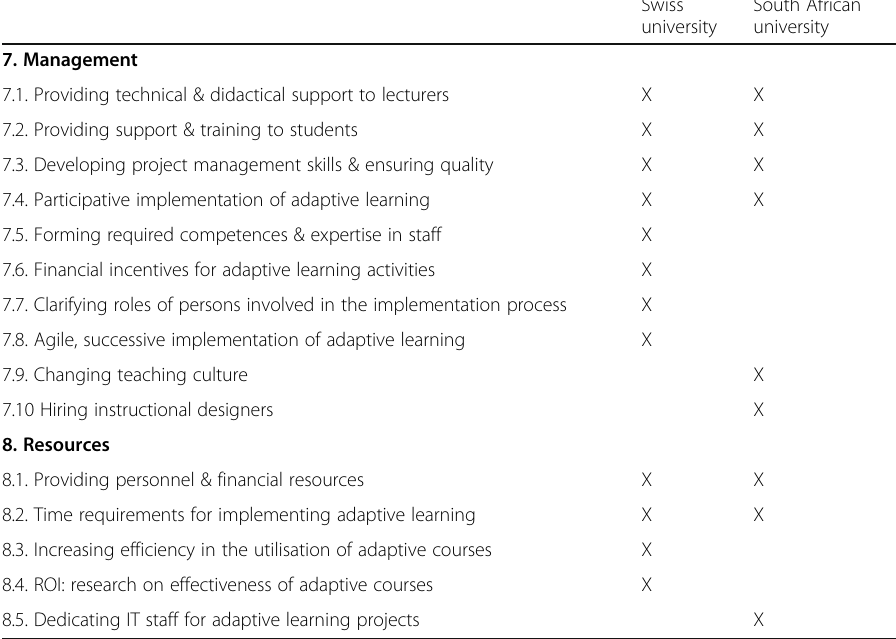
Table 2 Full List of Challenges of Adaptive Learning by Dimensions and Categories